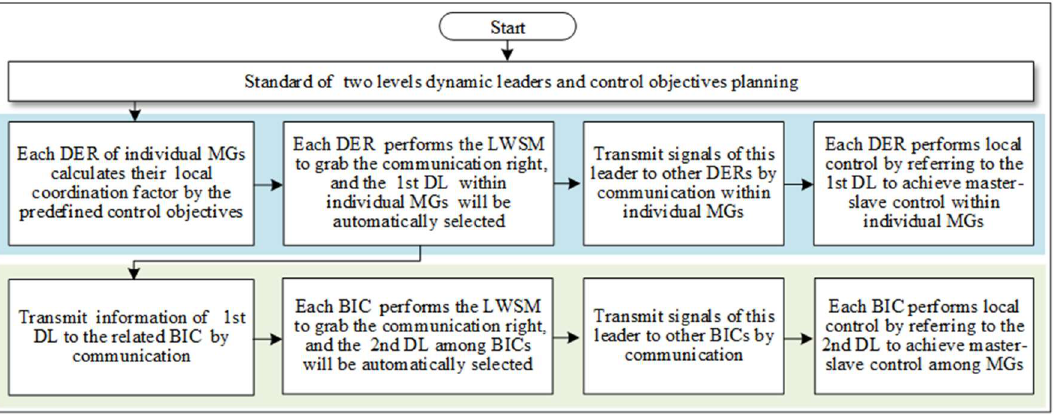
Figure 4. Flow chart of the proposed strategy.